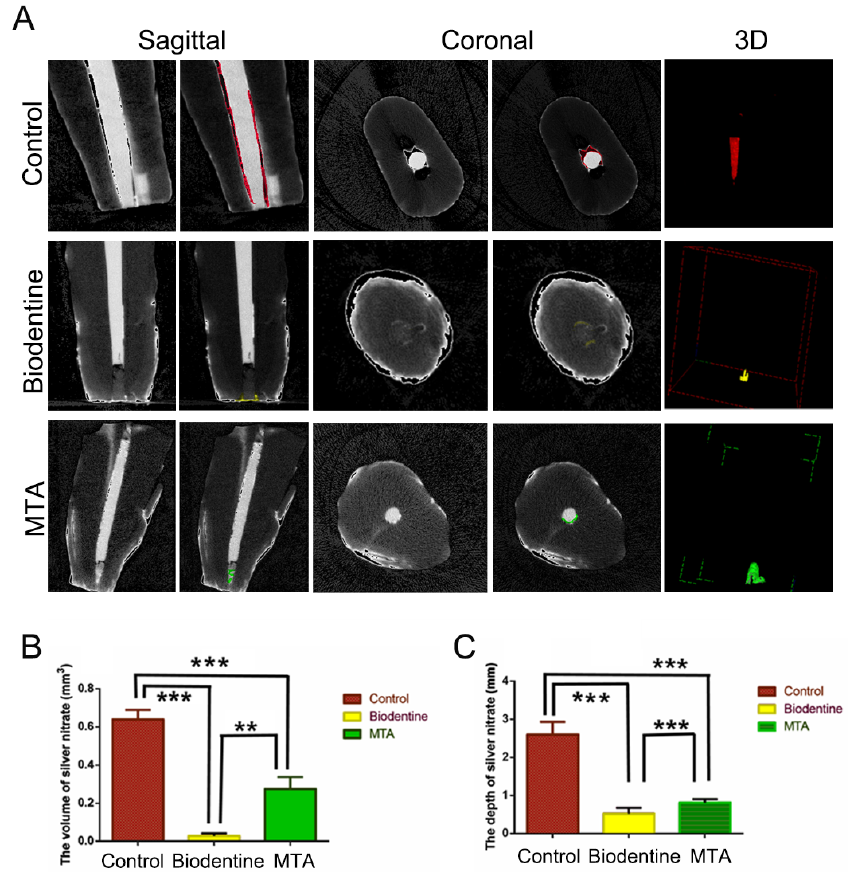
Figure 2- Determination of microleakage using a micro-CT analysis. (A) Micro-CT images showing the volume of the silver nitrate solution that infiltrated the root canal in each experimental group. (B) Quantitative analysis of the volume of the nitrate solution that infiltrated the root canal. (C) Quantitative analysis of the depth of the nitrate solution that infiltrated the root canal. **P < 0.01 and ***P <